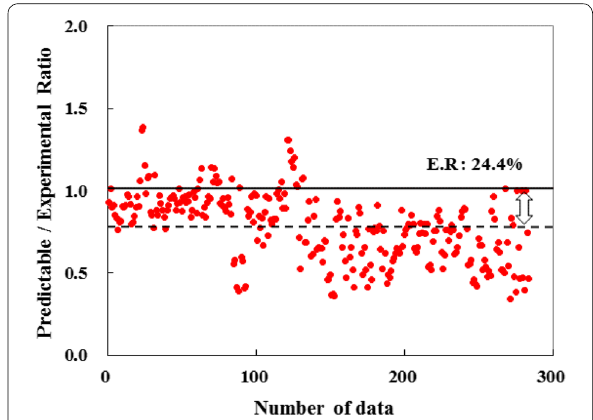
Fig. 7 Prediction ratio of confined concrete by Eq. (7).